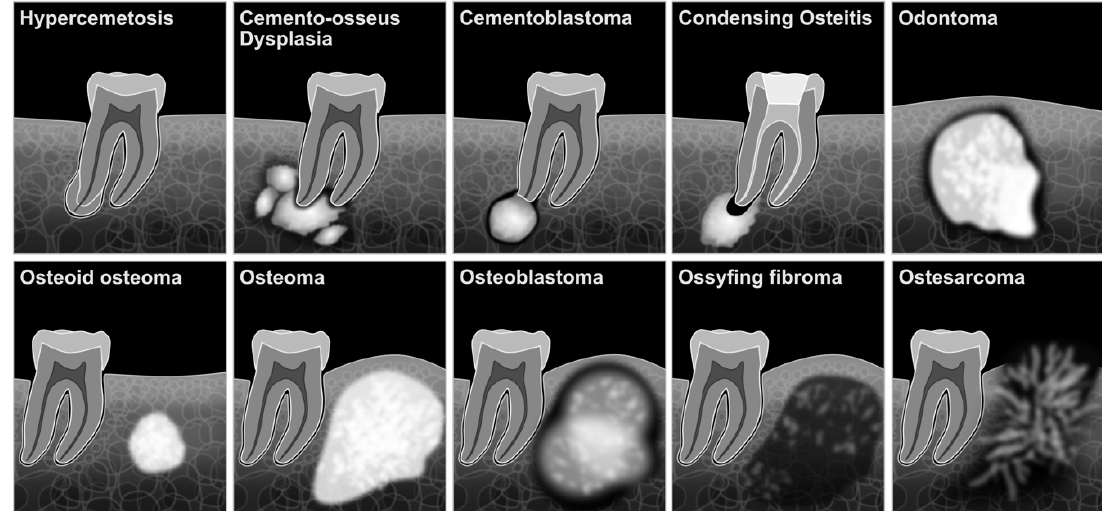
Figure 1. Schematic illustration of jaw bone lesions.